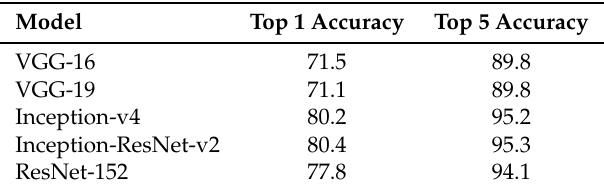
Table 2. Accuracies of different deep neural network models trained on the ImageNet Large-Scale Visual Recognition Challenge (ILSVRC)-2012-CLS. Top 1 accuracy: the class having the highest probability is the same as the true label. Top 5 accuracy: one class among the top 5 ranked classes (ranked according to decreasing probability) is the same as the true label